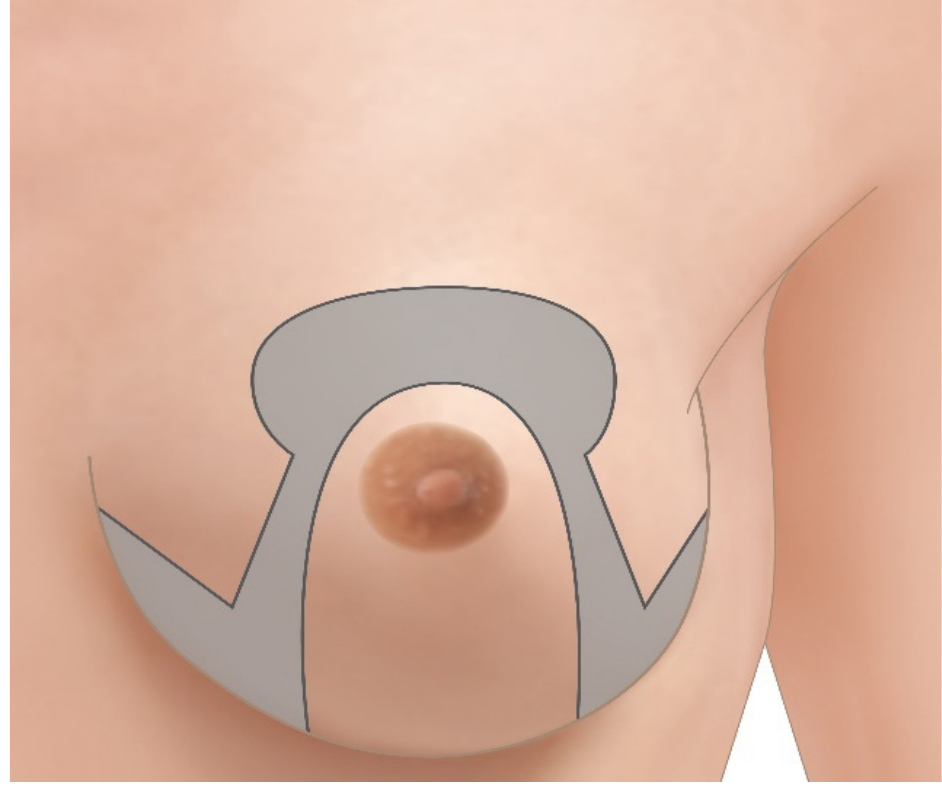
Figure 1. Schematic representation of omega pattern incision markings. The area marked in gray is resected en bloc.